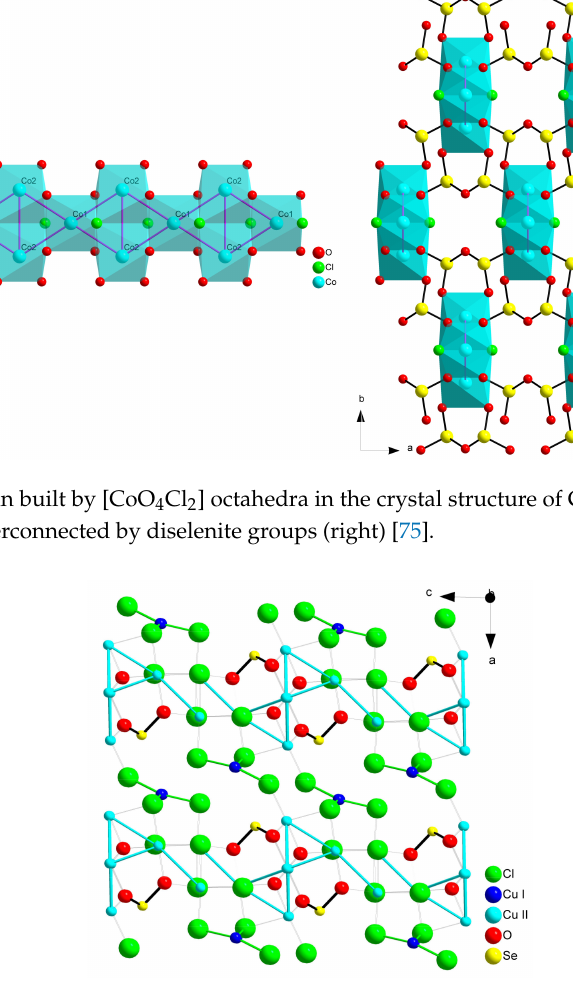
Figure 25. The complex chains of Cu 2+ ions in the structure of Cu I Cu II 4 O(SeO 3 )Cl 5 [74] separated by [Cu I Cl 3 ] 2– groups and decorated by SeO 3 2–